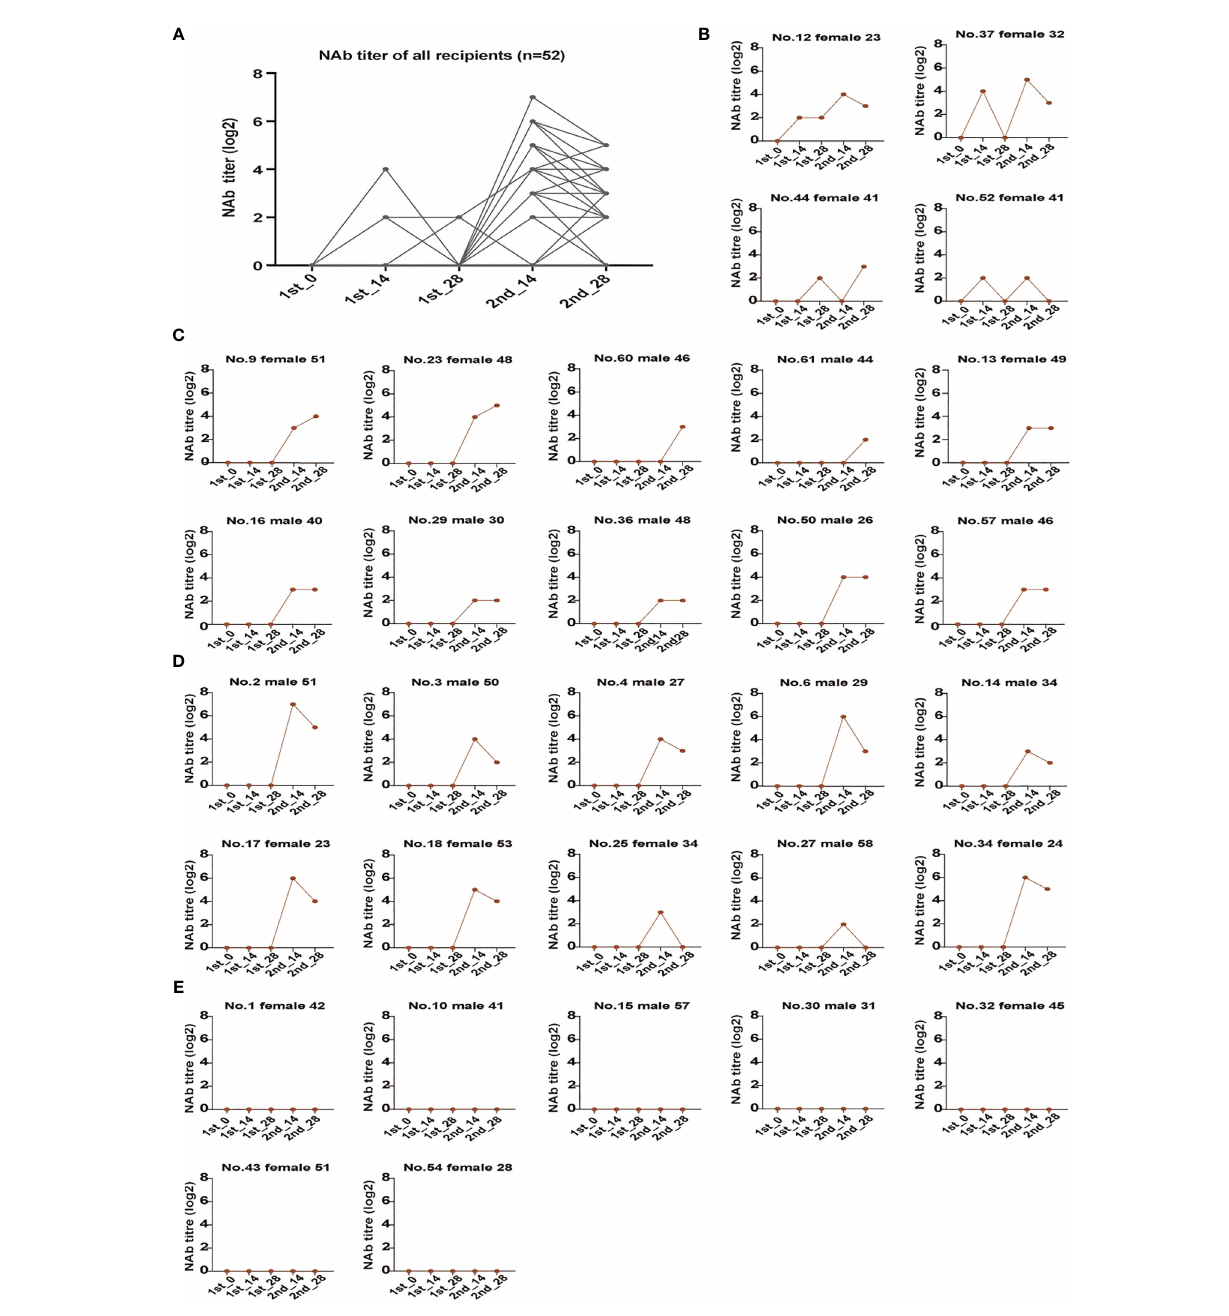
groups (with seroconversion, n = 43 and without seroconversion, n = 7) and compared the levels of baseline routine blood laboratory parameters between the two groups. Notably, among them, signi fi cantly low absolute lymphocyte counts,